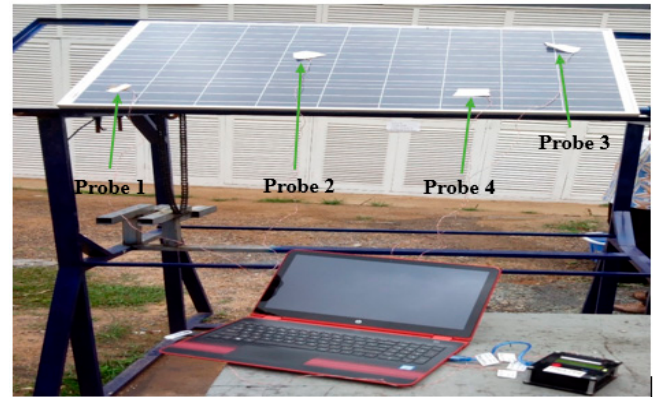
Figure 4. Setup for comparison of IR imager and temperature probes.